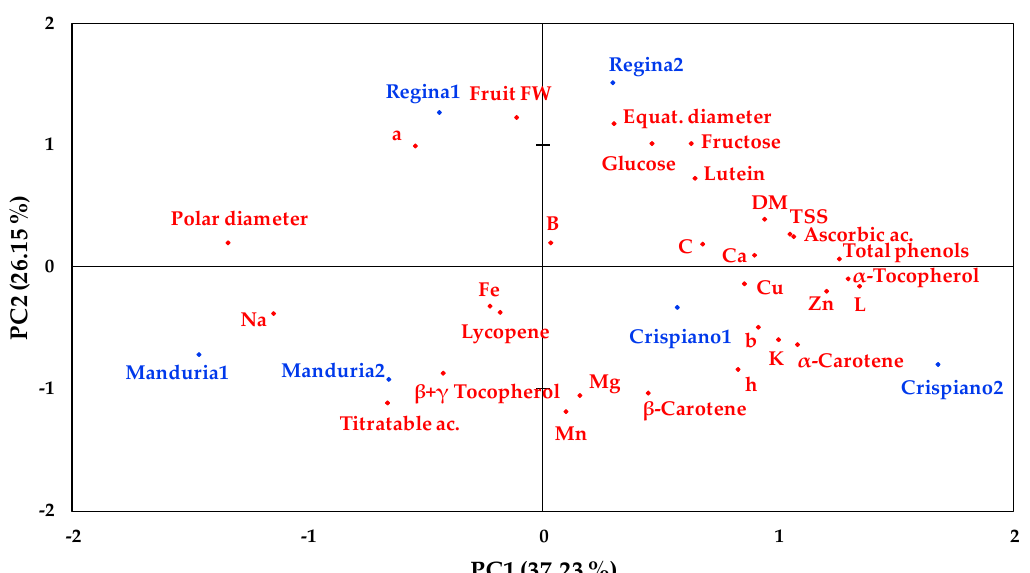
Figure 4. PCA biplot (Principal Component 1 - PC1 vs Principal Component 2 -PC2) describing the variation of the physical and chemical parameters used to characterize the three studied local tomato landraces. For each landrace, numbers 1 and 2 indicate the first and the second harvest, respectively. DM, dry matter; FW, fresh weight; L, lightness; C, color saturation; h, hue angle; a, red/green chromaticity; b, yellow/blues chromaticity; B, boron; Ca, calcium; Cu, cupper; Zn, zinc; Mg, magnesium; Mn, manganese; Na, sodium, K, potassium; Fe, iron.